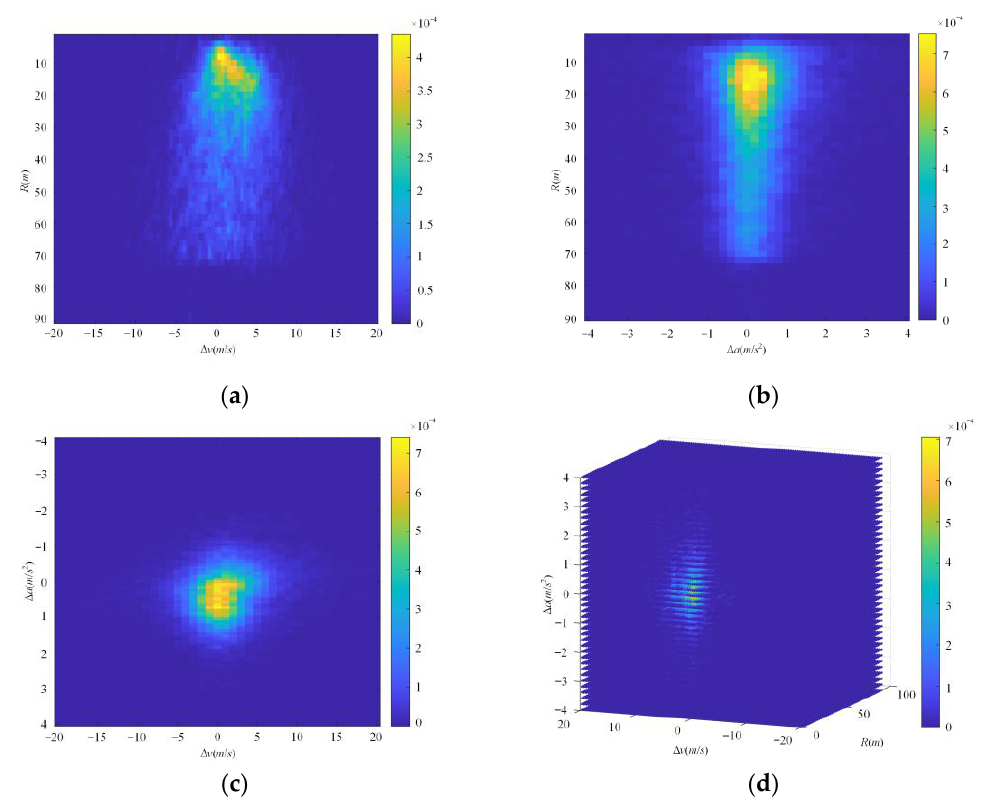
Figure 12. The occurrence probability distributions of the scenarios in ISSD. ( a ) The occurrence probability joint distribution of R and ∆ v between the ego vehicle and the object vehicle at the critical moment of cut-in scenarios; ( b ) the occurrence probability joint distribution of R and ∆ a between the ego vehicle and the object vehicle at the critical moment of cut-in scenarios; ( c ) the occurrence probability joint distribution of ∆ a and ∆ v between the ego vehicle and the object vehicle at the critical moment of cut-in scenarios; ( d ) the occurrence probability joint distribution of R , ∆ v and ∆ a between the ego vehicle and the object vehicle at the critical moment of cut-in scenarios.